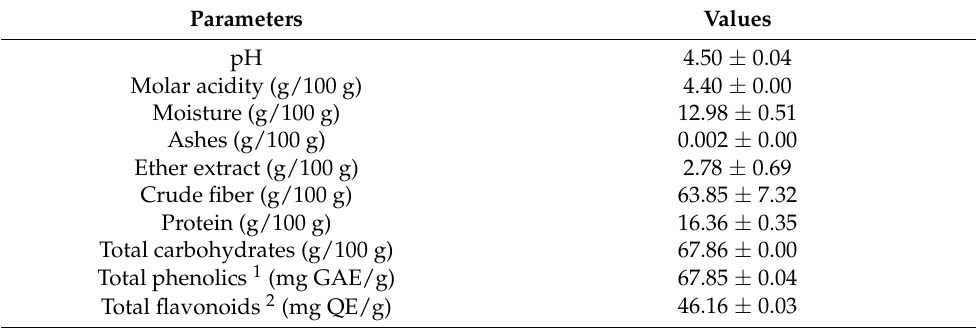
Table 1. Physicochemical analysis of N. cochenillifera hydroethanolic extract. Parameters